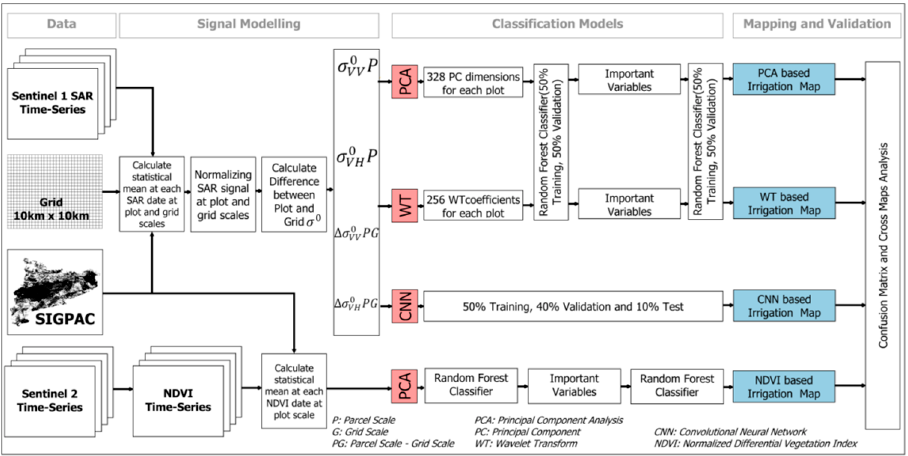
Figure 4. Workflow overview using random forest (RF) and the convolutional neural network (CNN).